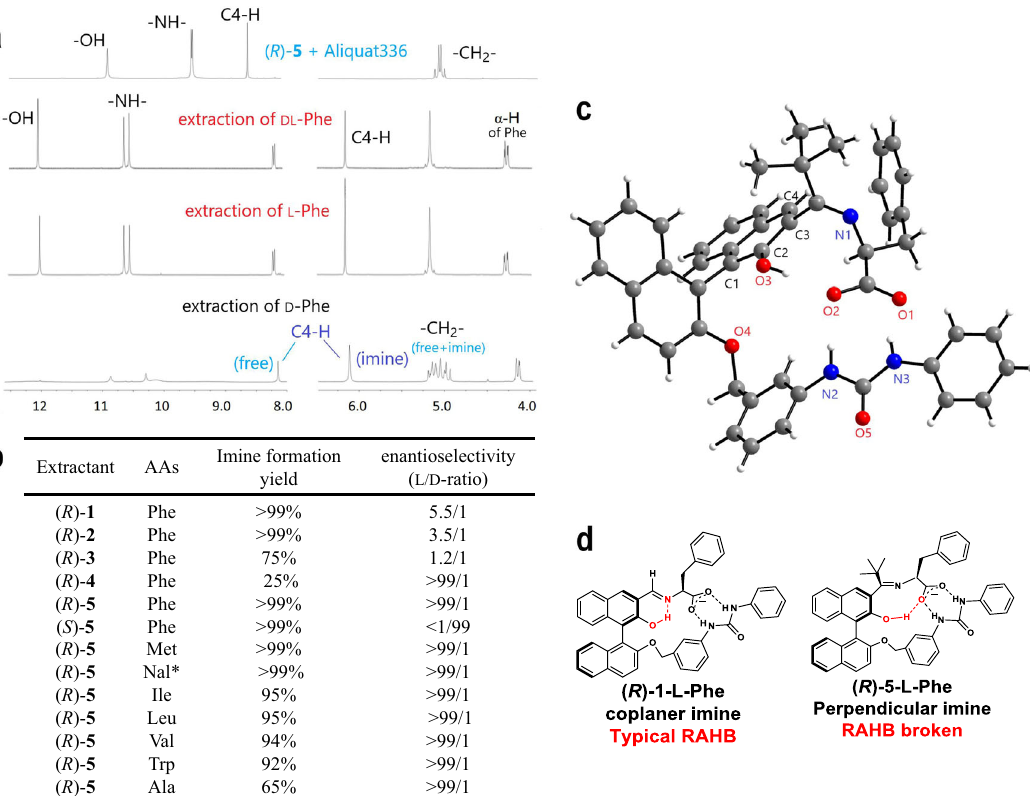
Fig. 2 The result of ELLE and the imine crystal structure. a Representative 1 H NMR spectra of the organic layer in the ELLE of Phe with ( R )- 5 : ( R )- 5 in the presence of Aliquat 336 (top); after ELLE of DL -Phe and separation of the organic layer (2nd row); after ELLE of L -Phe and separation of the organic layer (3rd row); after ELLE of D -Phe and separation of the organic layer (bottom). b The imine formation yields and enantioselectivities in the organic layers determined by 1 H NMR studies after the ELLE of AAs with 1 – 5 . General ELLE conditions: organic layer, 0.10 M extractant and 1.05 equiv. Aliquat 336 in 1 mL CDCl 3 ; aqueous layer, 1.0 M DL -AA in 1 mL H 2 O with pH 12.0 at 25 °C; 12 h stirring. *Nal stands for naphthylalanine, an unnatural amino acid. c The